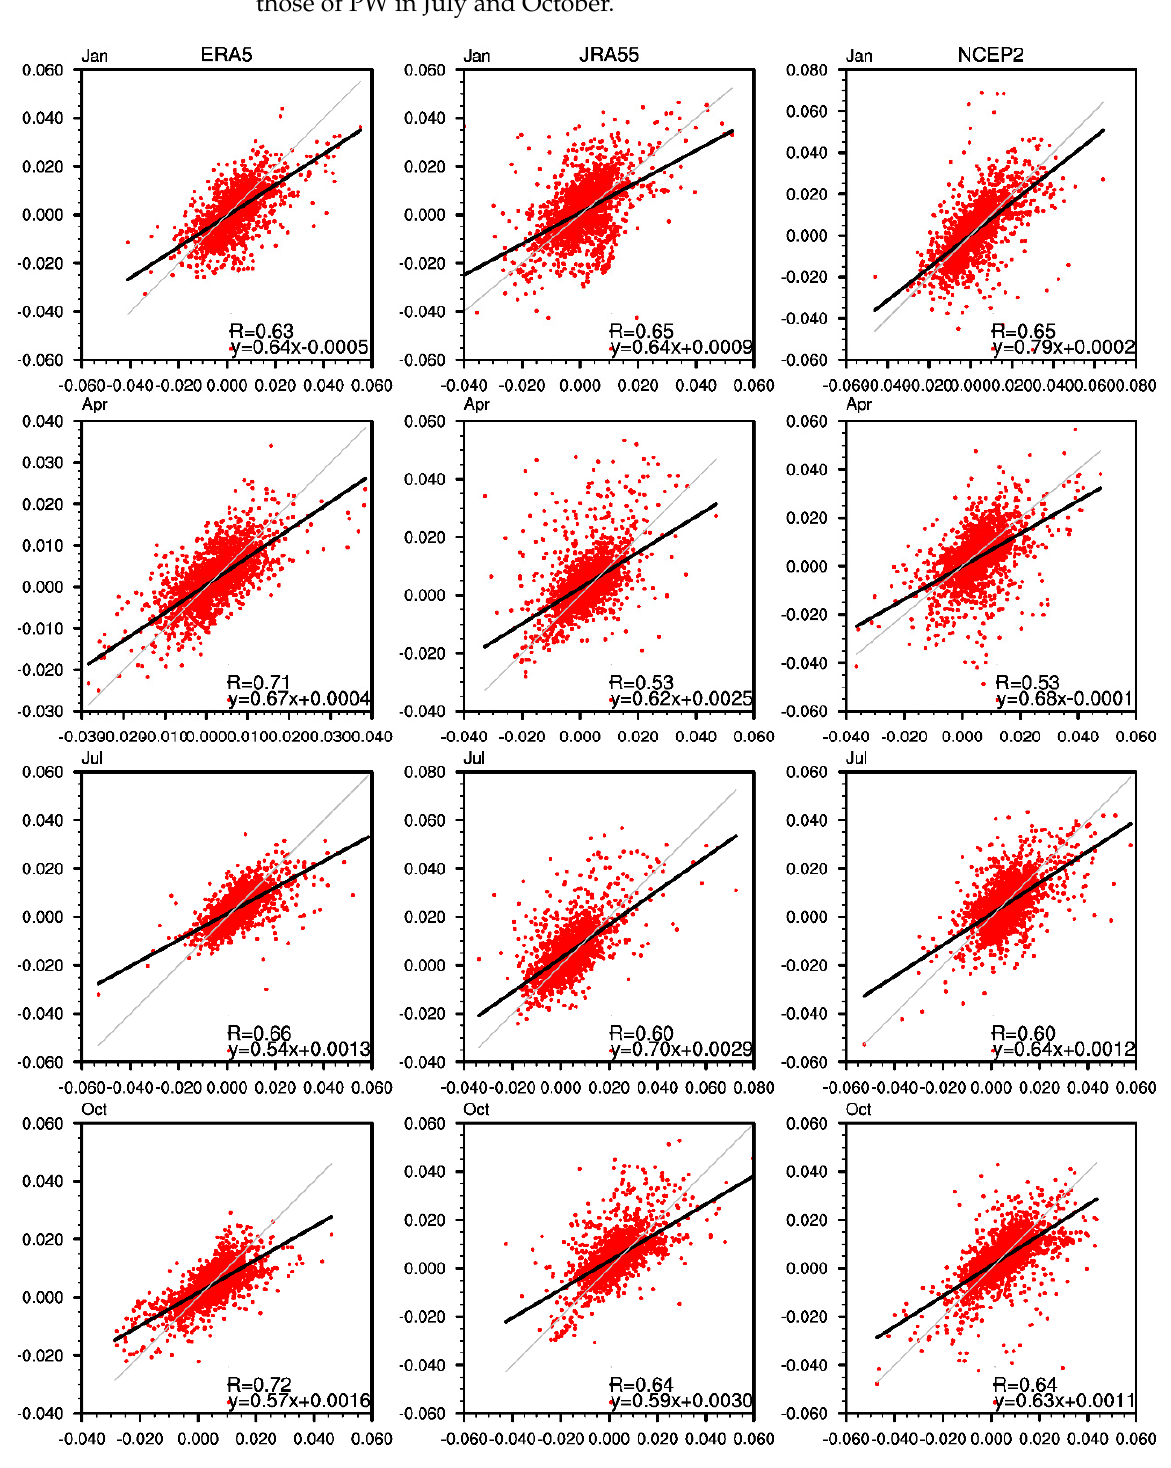
Figure 7. Scatter plots of PW and SVP trends at grids in four months. Each dot is a grid. The columns from left to right correspond to ERA5, JRA55, and NCEP2. The rows from top to bottom correspond to four months. The black line is the linear regression line of PW and SVP. The grey line is the y = x line. R is the spatial correlation coefficient of PW and SVP. The equation in the right bottom corner is the regression equation.